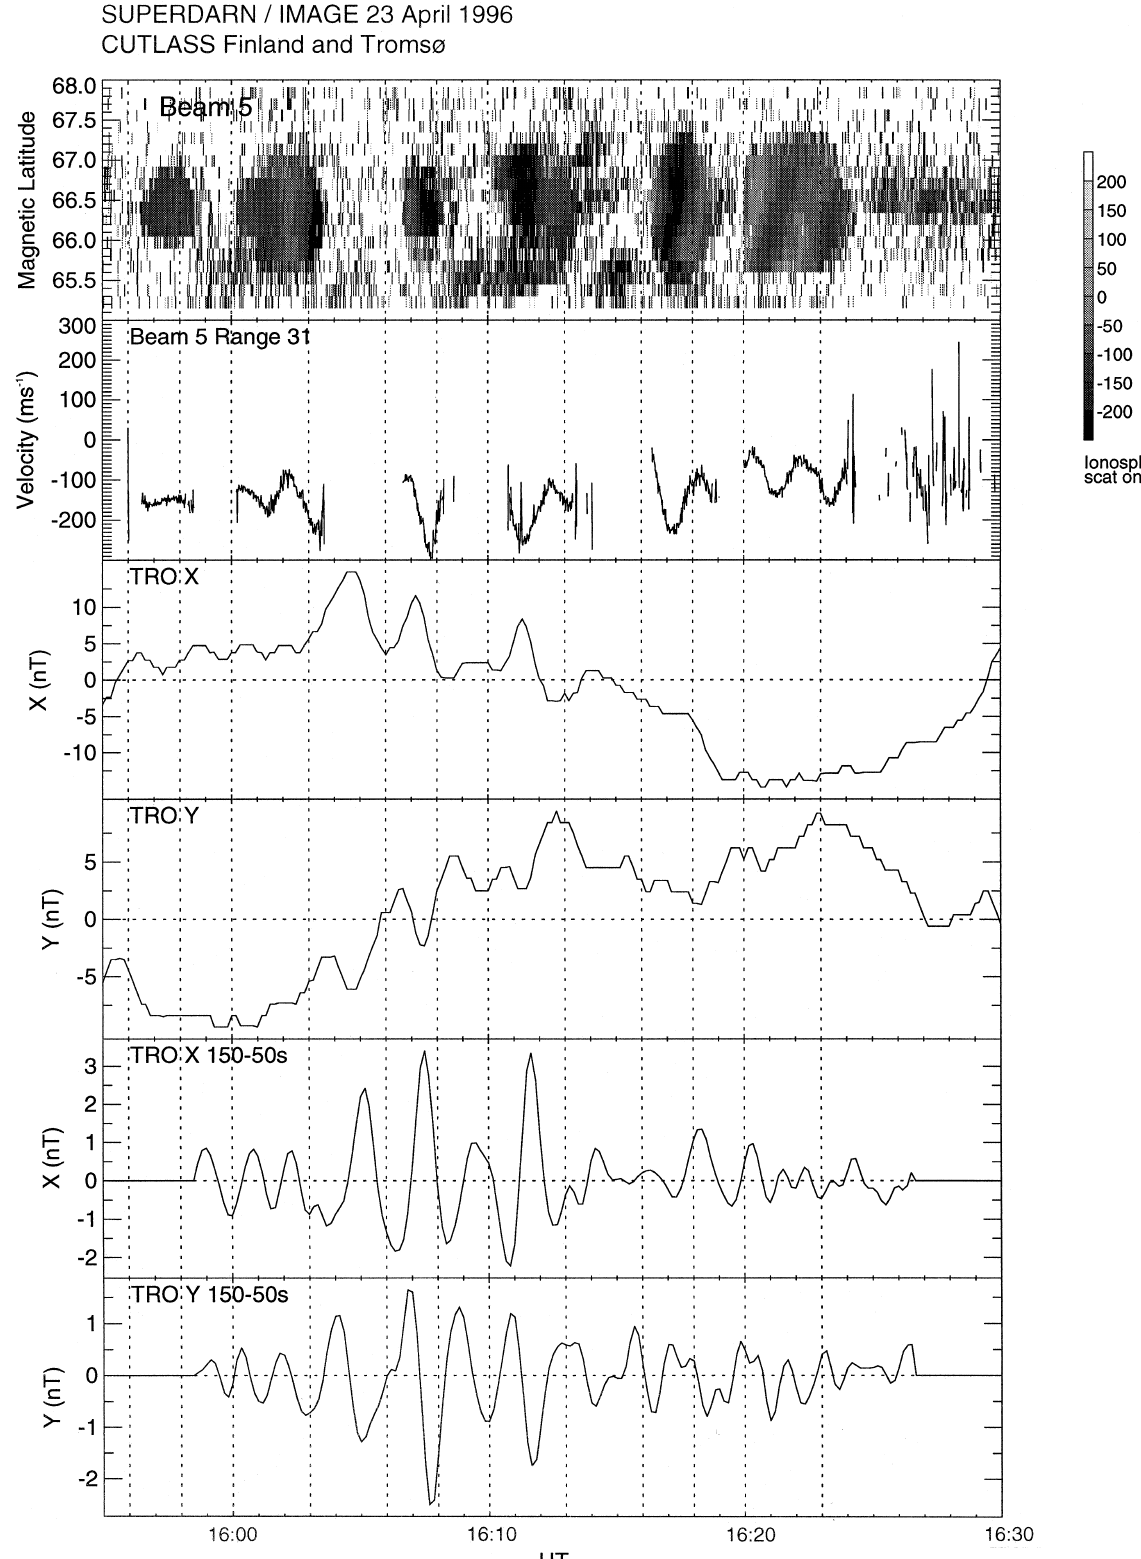
lines ). The second panel plots a time series for a single range gate, gate 31, which overlies the Tromsø magnetometer. Filtered (150 – 50 s, 6.67 – 20 mHz) and unfiltered X and Y component magnetic field measurements are presented in the lower four panels. A correlated ULF wave signature can be seen in data from